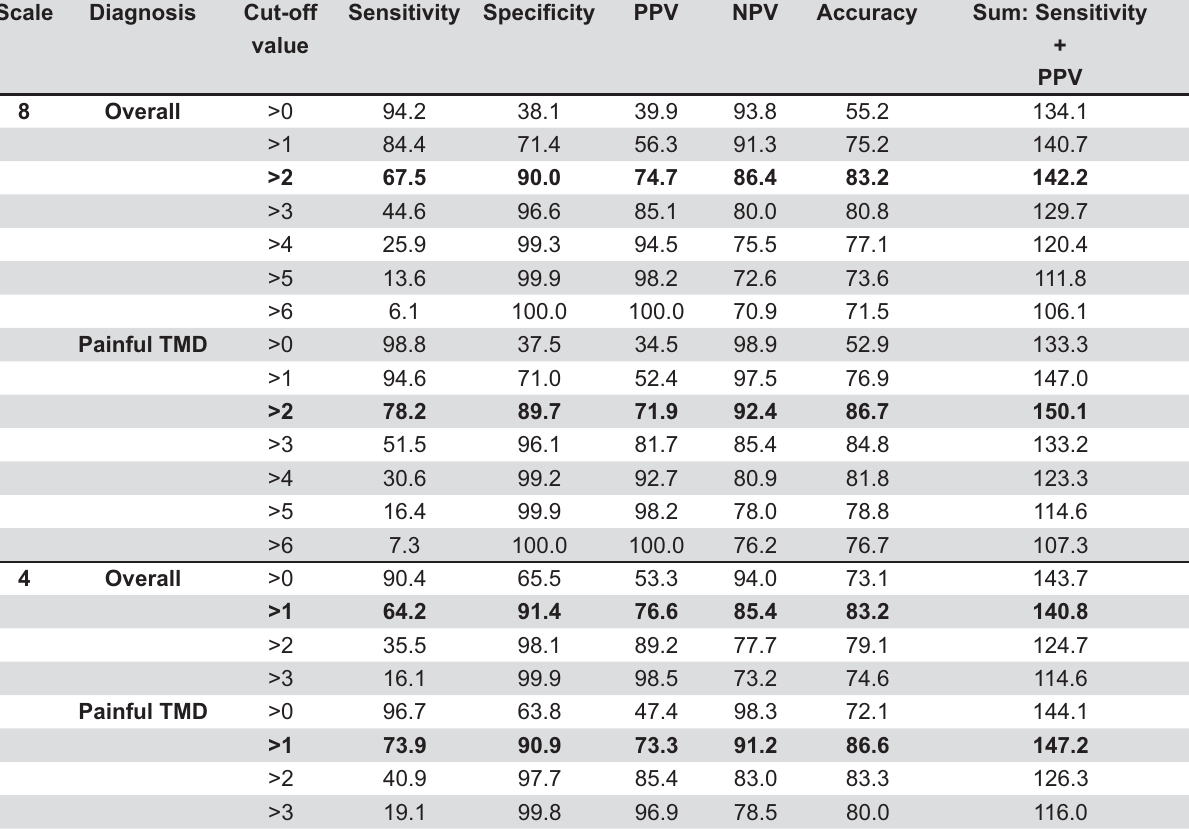
TMD: temporomandibular disorders; PPV: positive predictive values; NPV: negative predictive